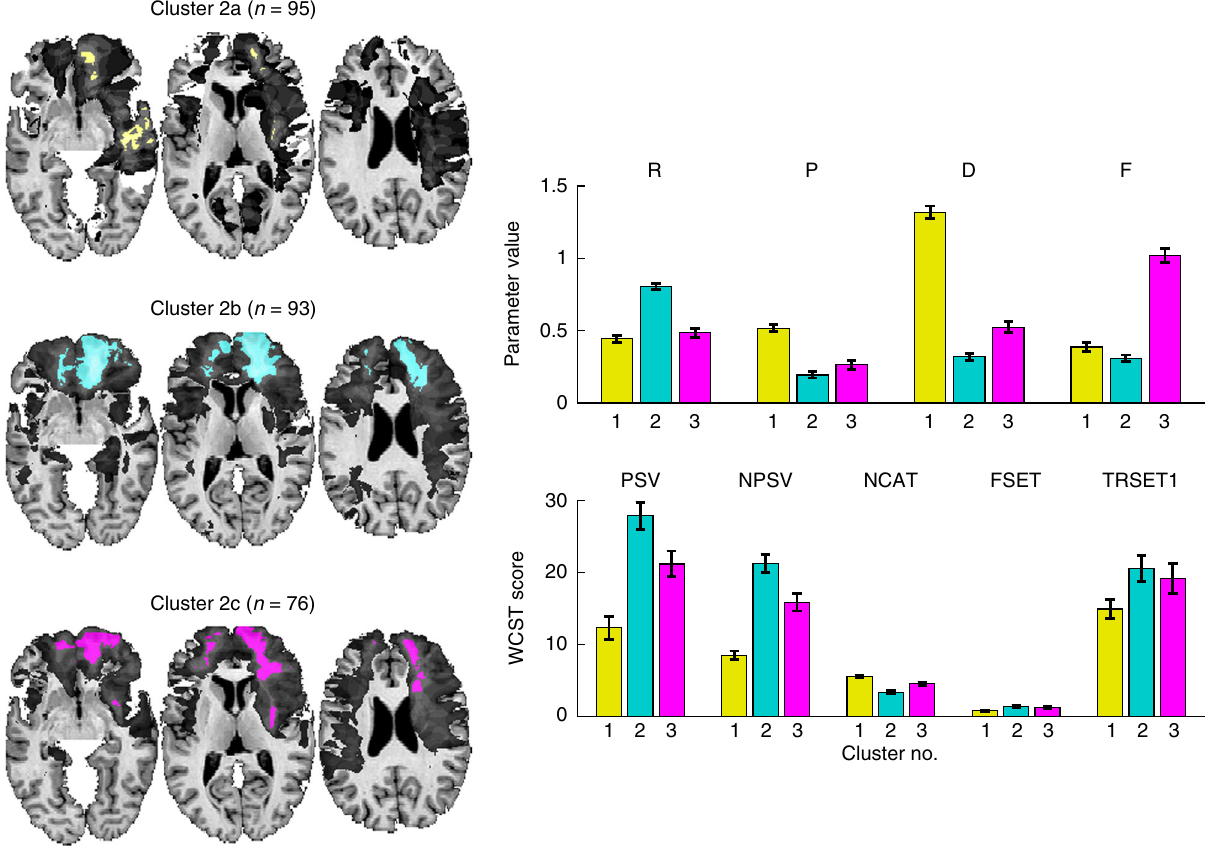
Fig. 6 Cluster analysis of participants derived from cluster 2 of the fi rst analysis (Fig. 5). This second analysis identi fi ed three further subgroups of participants who differed in their model parameters and WCST scores (mean individual MAP estimate ±